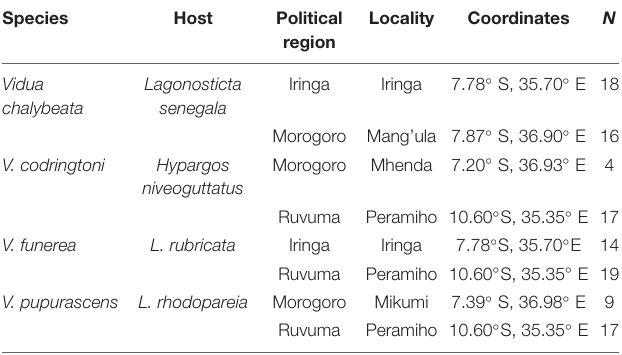
TABLE 2 | Elevation, temperature, and precipitation data for sampled regions during the indigobird breeding season. Ave. high Ave low Ave temp ( ◦ C) temp ( ◦ C) precip